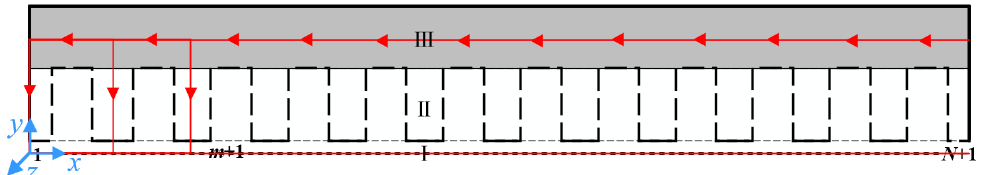
Figure 3. Diagram of the simplified model.